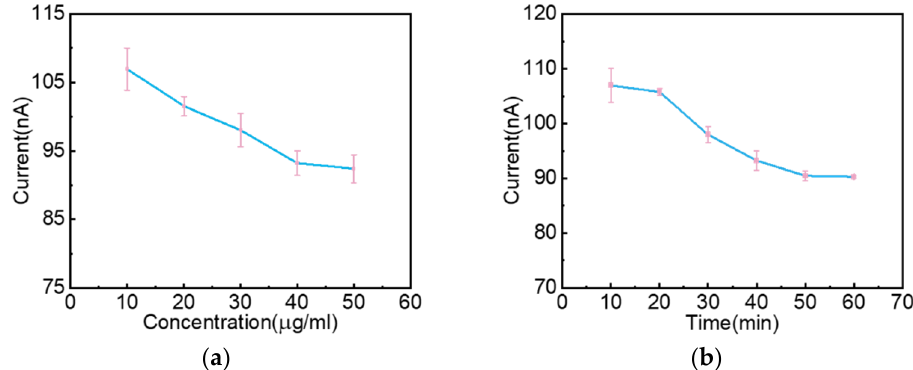
Figure 5. Parameter optimization. Influence of ( a ) antibody concentration used for capturing exosome on the working electrode and ( b ) incubation time of antibody on peak current responses of DPV.